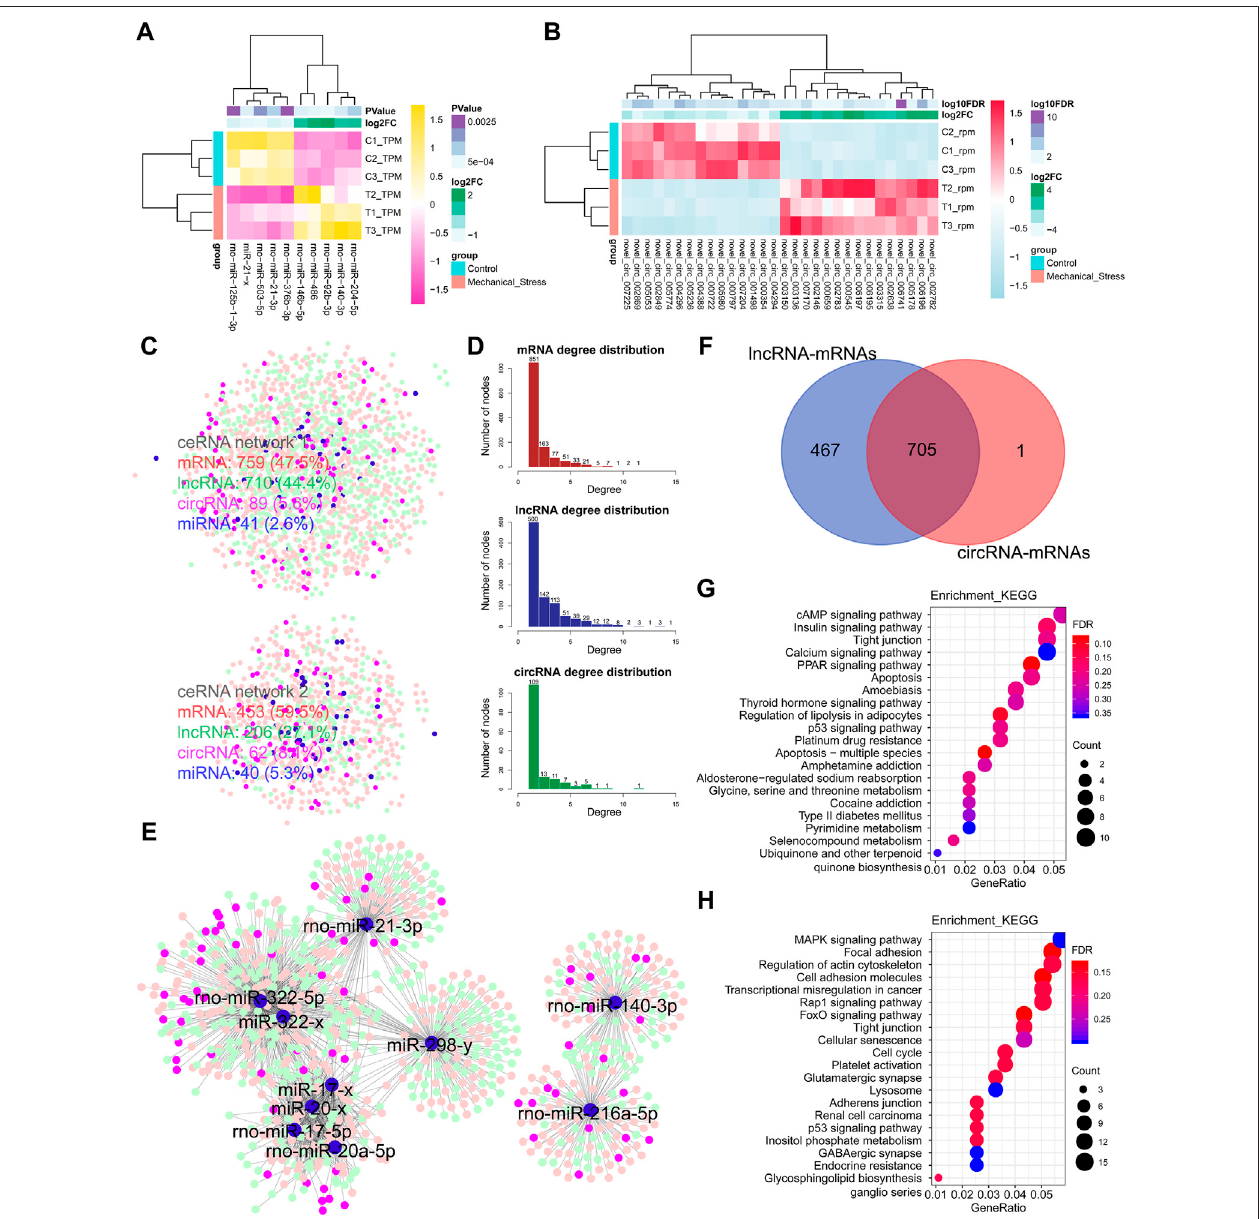
FIGURE4| NotableinvolvementoflncRNAsinceRNAregulationnetworks. (A) Top5up-ordownregulated miRNAs(DEMIs)intherankof p -value. (B) Top15up- ordownregulatedcircRNAs(DECs)intherankofFDR. (C) miRNA-centricceRNAregulationnetworksconstructedbyDEMs(red),DEMIs(blue),DELs(green),andDECs (purple). In the ceRNA network 1, DEMs, DELs, DECs, and DEMIs account for 47.5%, 44.4%, 5.6%, and 2.6%, respectively. In the ceRNA network 2, DEMs, DELs, DECs,andDEMIsaccountfor59.5%,27.1%,8.1%,and5.3%. (D) ThedegreedistributionofDEMs,DELs,andDECsinceRNAnetworks.Thedegreeisde fi nedas thenumberofnodesconnected.Thedegree > or=5isde fi nedashighconnectivityinnetworks.TheDELswithhighconnectivityaremorethantheDEMs,whiletheDELs withthedegree lowerthan 5areless than DEMs. (E) The essentialmiRNA-centric subnetworks. (F) Theoverlap oftheDEMs connected toDELs orDECs. Atotalof705 DEMs are de fi ned as the commonly regulated genes by lncRNAs and circRNAs, accounting for > 99.9% in the DEMs regulated by circRNAs. A total of 467 DEMs are de fi nedasthelncRNAspeci fi callyregulatedgenes. (G) TheKEGGpathwayanalysisofthelncRNAspeci fi callyregulatedgenesbytheORAmethod.Thecolorandsizeof dot represent FDR and count of the genes assigned into the corresponding KEGG pathway, respectively. FDR, false discovery rate, p -value estimated by one-way ANOVA and adjusted by the Benjamini – Hochberg method. GeneRatio indicates the gene number ratio in each KEGG pathway. (H) The KEGG pathway analysis of the commonly regulated genes by the ORA method.